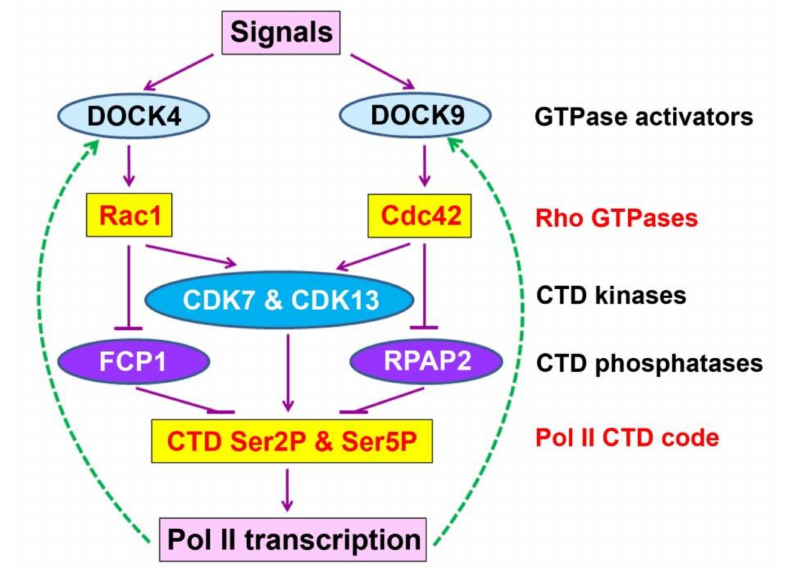
Figure 6. A hypothetical model for the Rho-Pol II signaling shortcut in transcriptional control in cultured human cells. Once activated by extracellular signals, Rac1 and Cdc42 GTPases positively control the degradation of CTD kinases (CDK7 and CDK13) but negatively and di ff erentially control the degradation of CTD phosphatases (FCP1 for Rac1 and RPAP2 for Cdc42) in modulation of the Pol II CTD code (Ser2P and Ser5P). Feedback regulation of DOCK4 and DOCK9, the activators of Rac1 and Cdc42, respectively, is hypothesized to be achieved by transcriptional control of these DOCK genes (indicated by dotted green